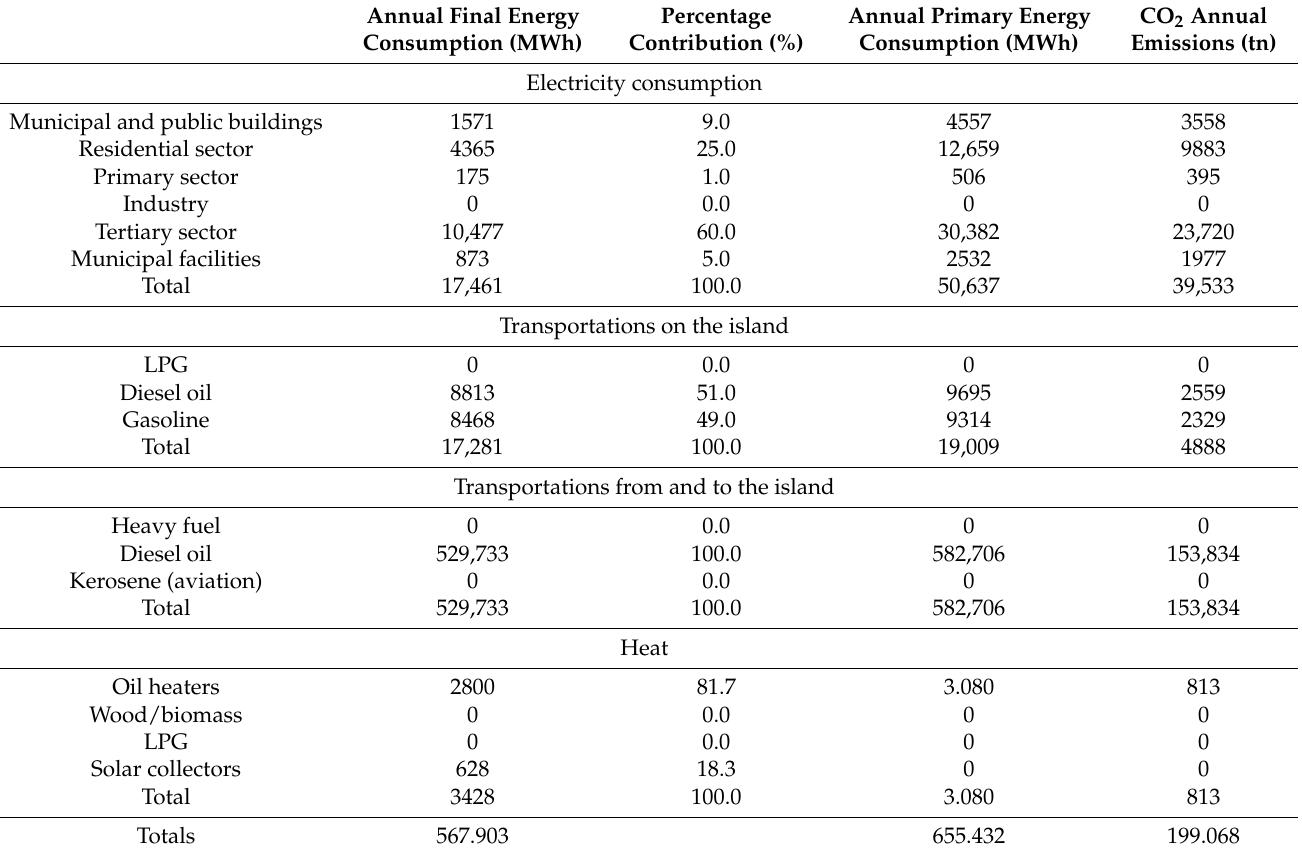
Table 1. Analysis of annual energy consumptions on